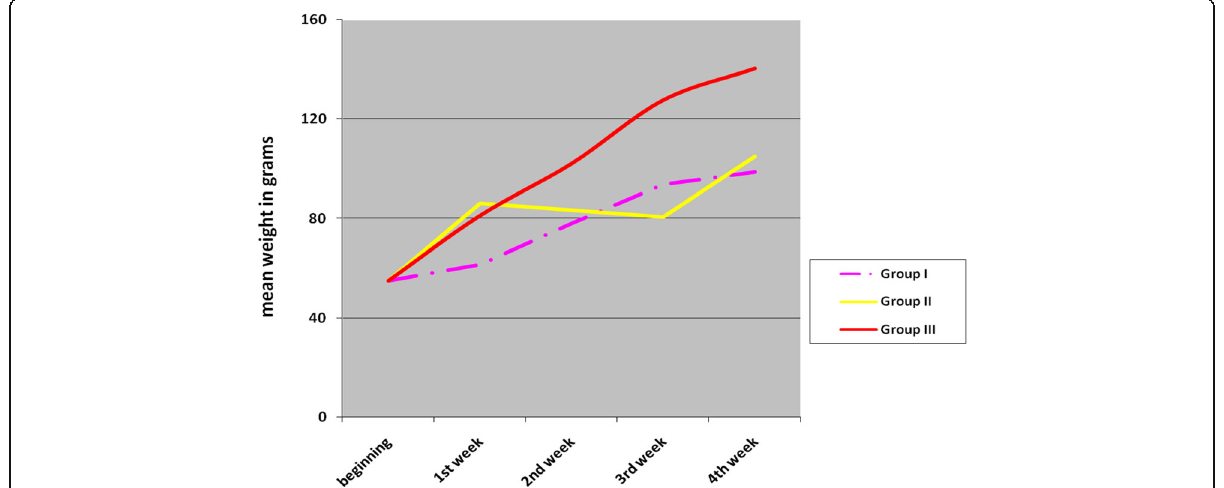
Fig. 1 Linear graph showing the relation between weight gain in rats treated with MSG for one month; Group II (high dose), Group III (low dose) and control